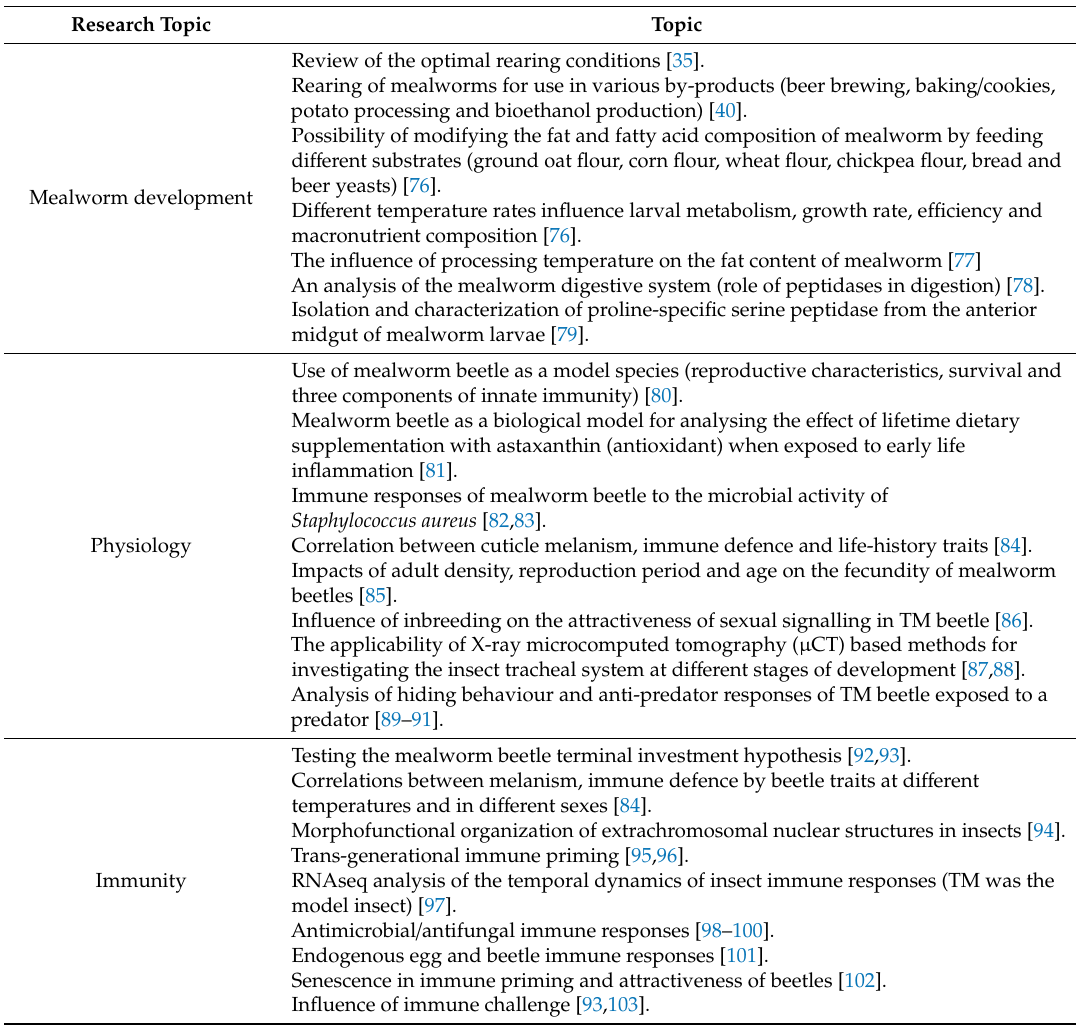
Table 1. Selected European studies on mealworm growth, physiology and